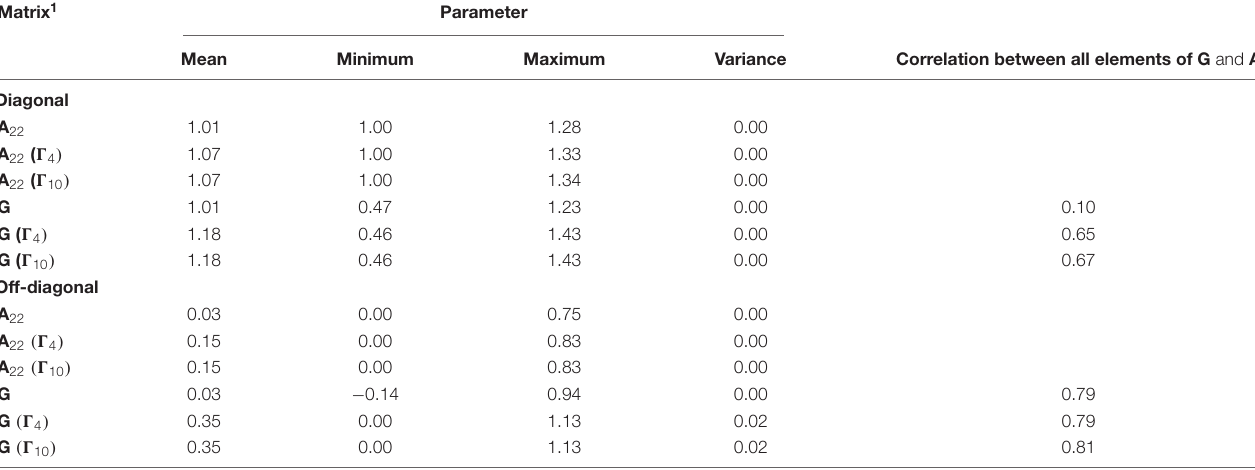
TABLE 3 | Descriptive statistics for diagonal and off-diagonal elements of genomic matrices required for genomic evaluations with and without metafounders. Matrix 1 Parameter Mean Minimum Maximum Variance Correlation between all elements of G and A